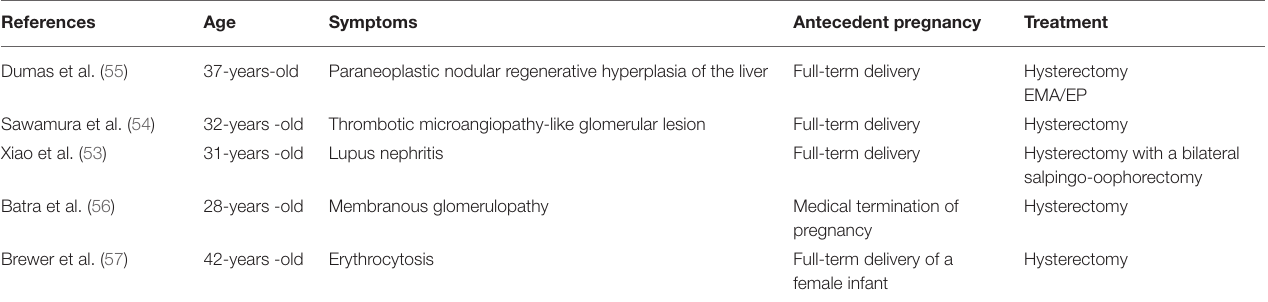
TABLE 2 | Atypical presentations of PSTT